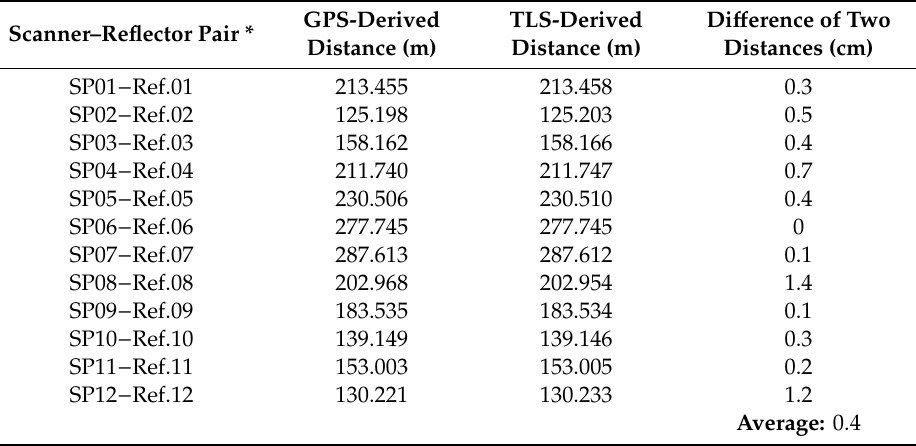
Table 1. Scanner-to-reflector distances derived from GPS and TLS measurements.